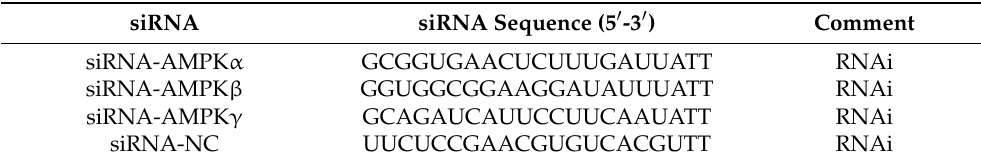
Table 3. The sequence of